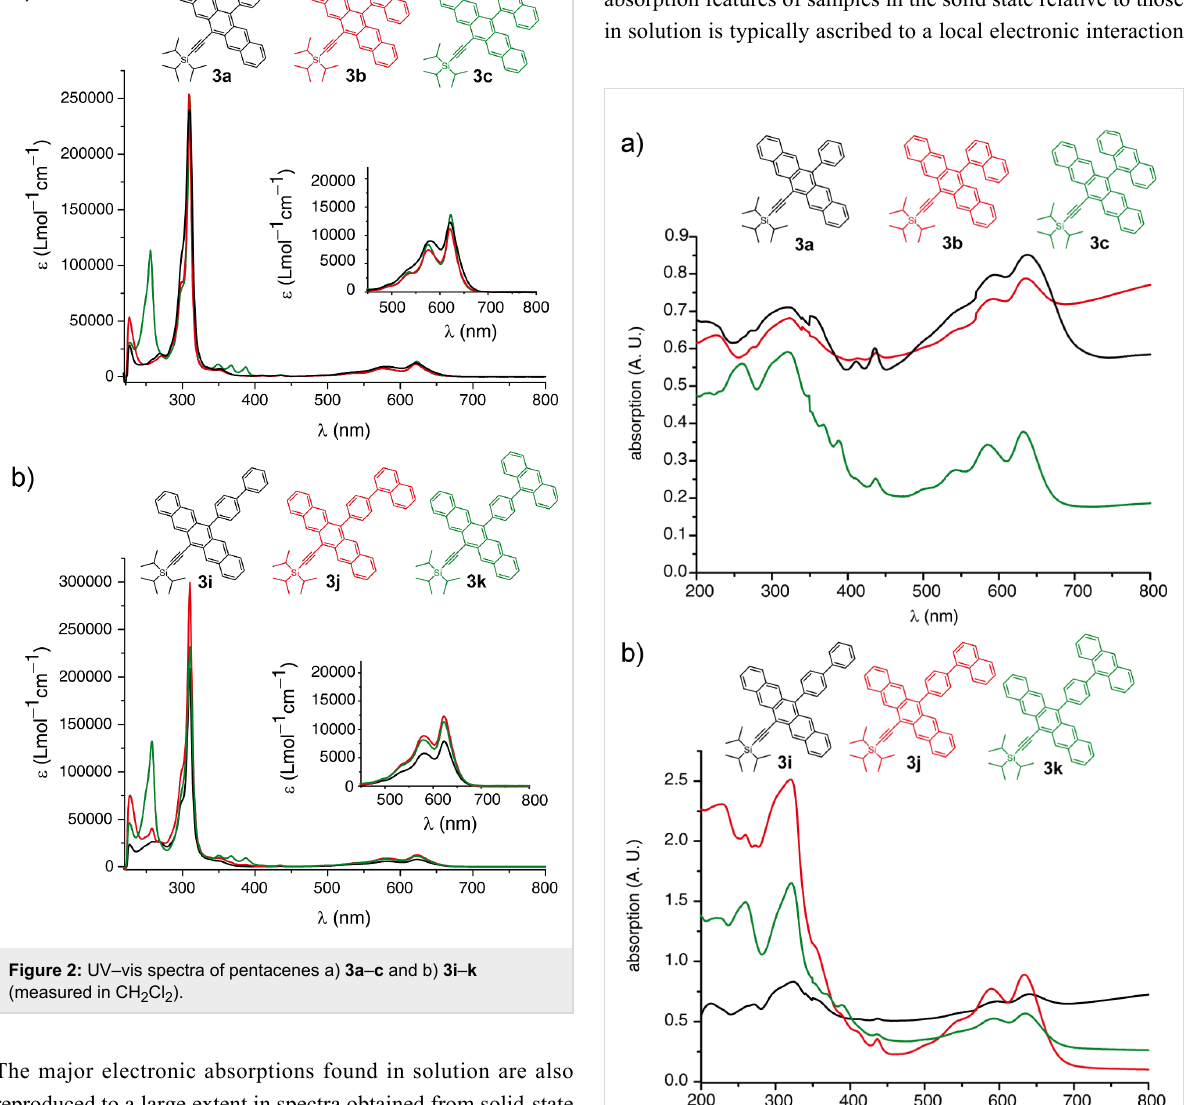
The major electronic absorptions found in solution are also reproduced to a large extent in spectra obtained from solid-state films. Pentacene samples 3a – k were drop-cast from a concen- trated CH 2 Cl 2 solution onto a quartz surface, and after air- drying, the absorption spectra were measured by UV–vis spec- troscopy (Figure 3 and Table 1). While this method sometimes